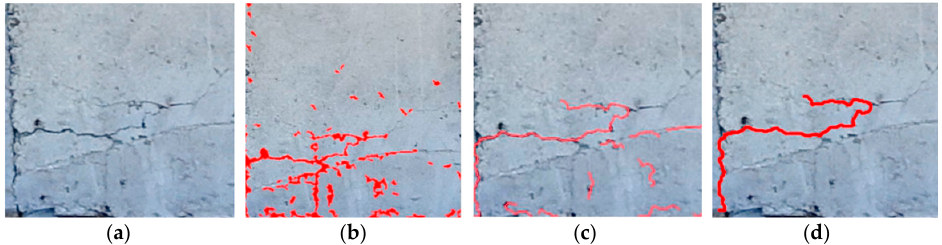
Figure 16. Crack identification: ( a ) original image; ( b ) binary image; ( c ) image obtained after noise removal and skeletonization; ( d ) main cracks.